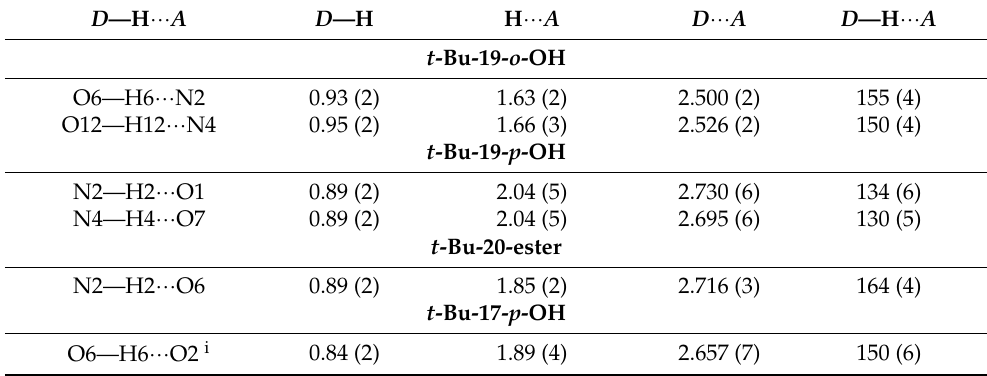
Table 2. Hydrogen bond geometry (Å, °).